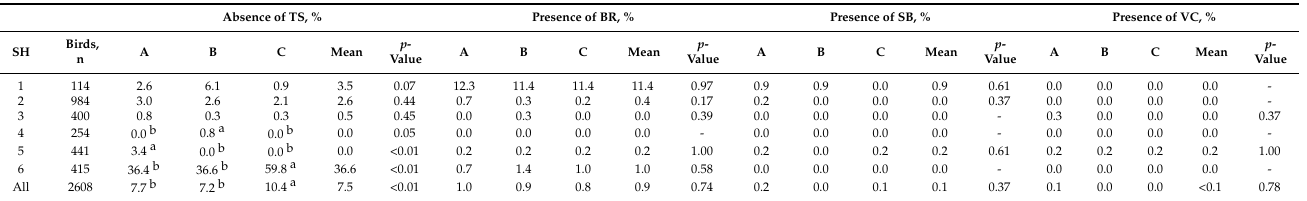
Table 5. Percentage of the outcomes of the animal-based indicators for the state of consciousness in broilers after waterbath stunning but before bleeding according to the observer (A to C) and slaughterhouse (SH) assessed.